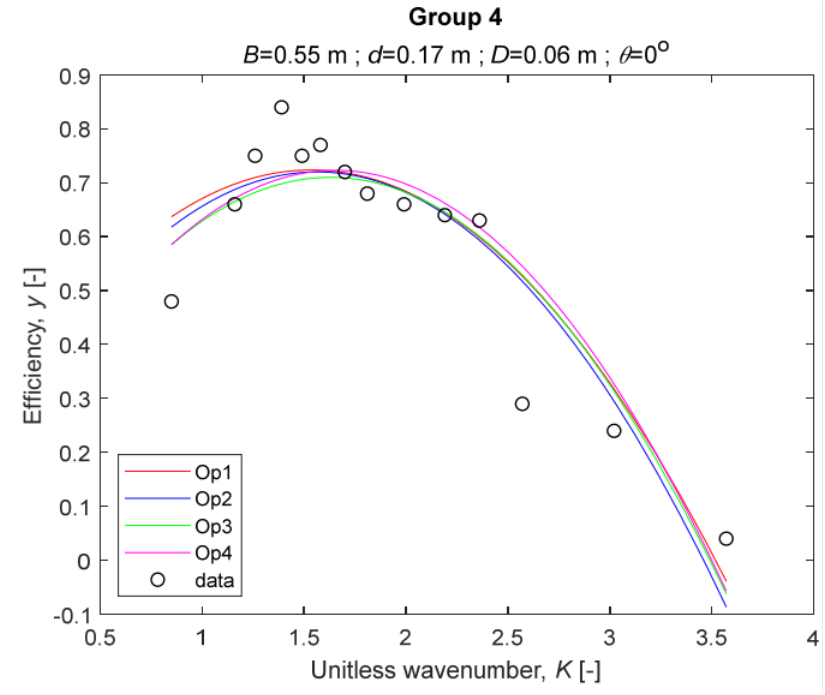
Figure 6. The four models for Group